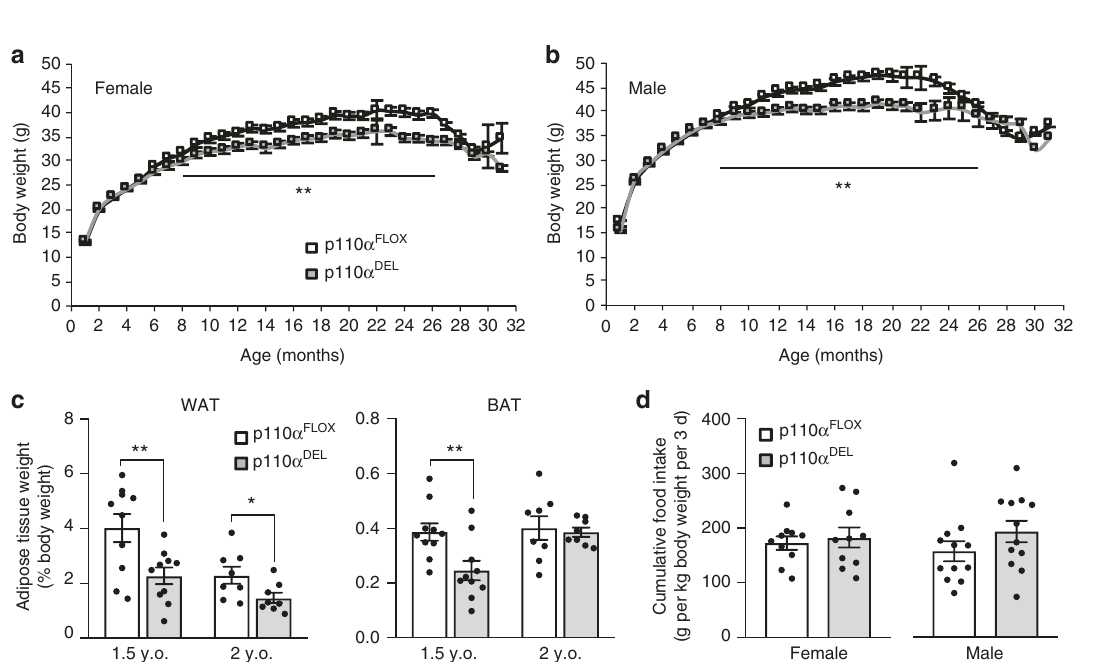
Fig. 6 p110 α DEL mice display increased catecholamine-stimulated energy expenditure. a mRNA-expression levels of brown adipocyte markers in adipose tissues isolated from 18-week-old p110 α DEL and p110 α FLOX littermate male mice ( n = 4 per genotype) following intraperitoneal administration of the β 3 -AR selective agonist CL316,243 (1 mg per kg per day) over fi ve consecutive days. RNA was extracted from inguinal and epididymal adipose tissues and mRNA